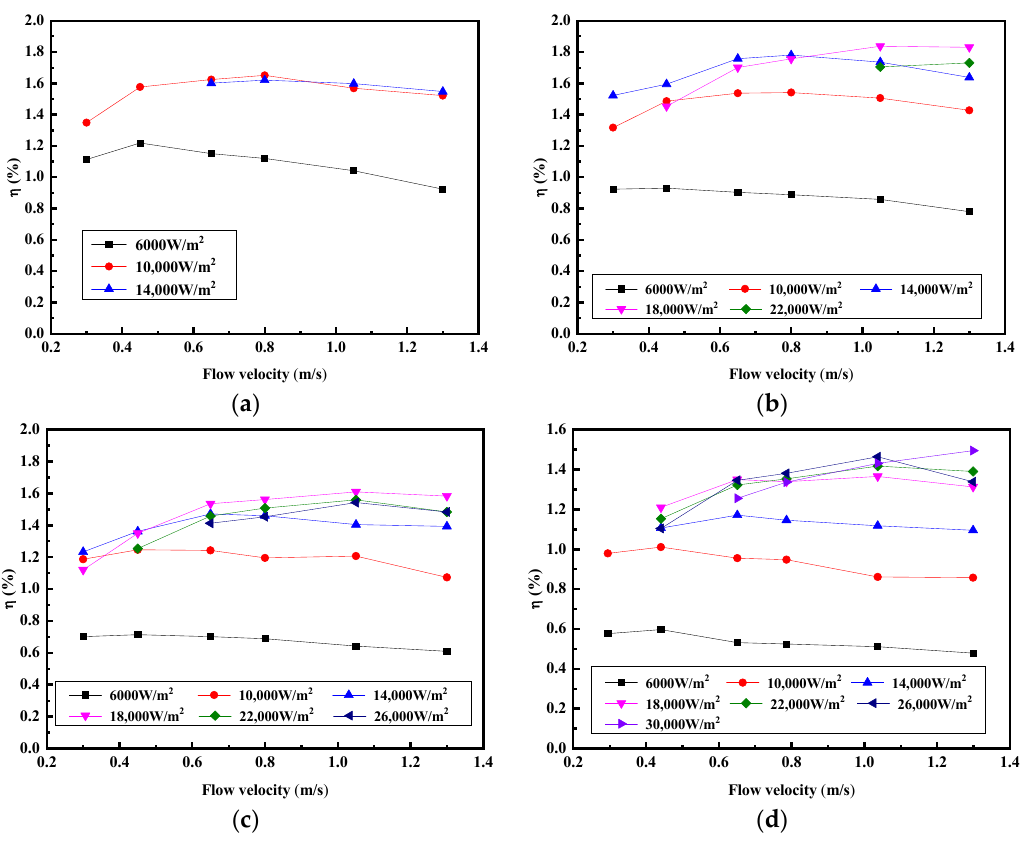
Figure 7. ( a ) one module, ( b ) two modules, ( c ) three modules, ( d ) four modules. Thermoelectric efficiency at various air flow velocity and heat flux. efficiency at various air flow velocity and heat